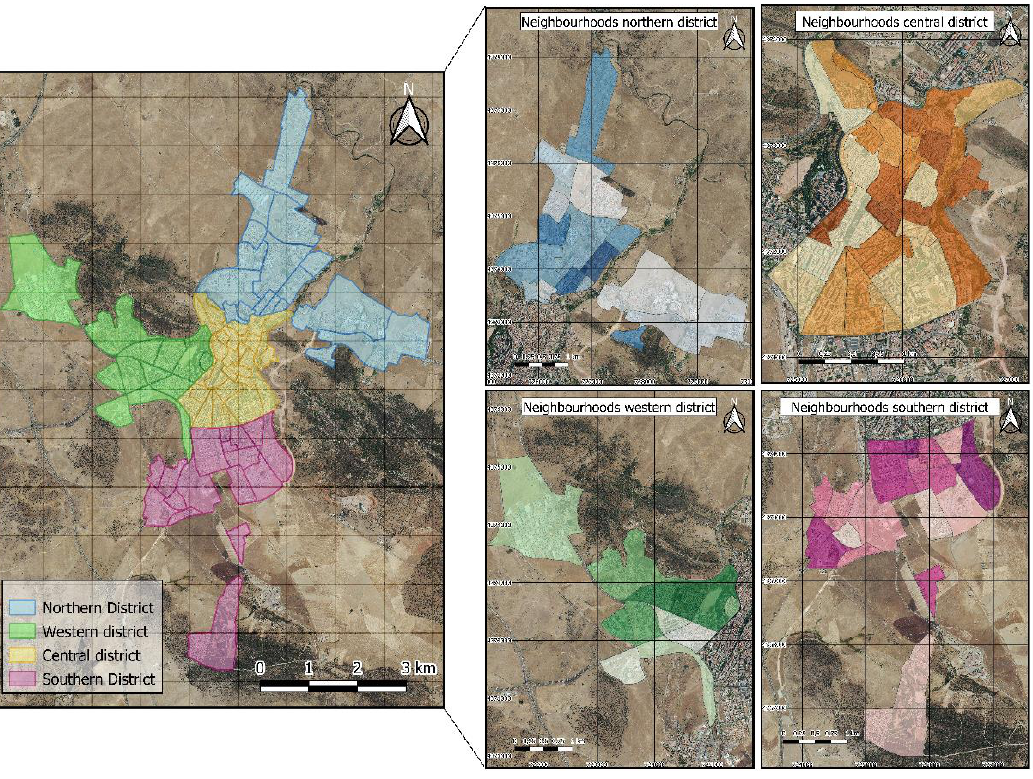
Figure 2. Map of the districts of Cáceres.